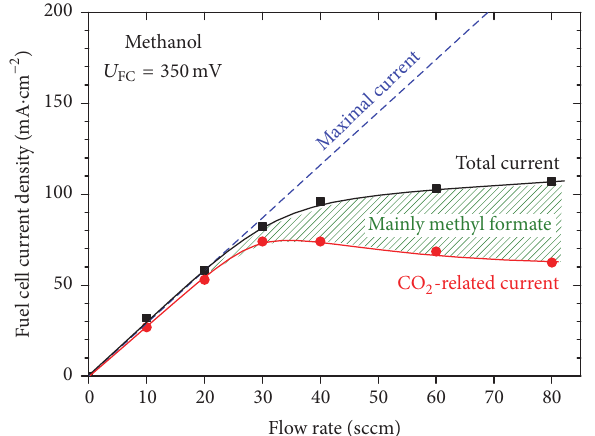
Figure3:DMFCcurrentasafunctionoftotalfuelmixtureflowrate. Methanol concentration in the feed was 2 M, cell potential 350 mV. The dashed blue line represents the ideal line of maximal